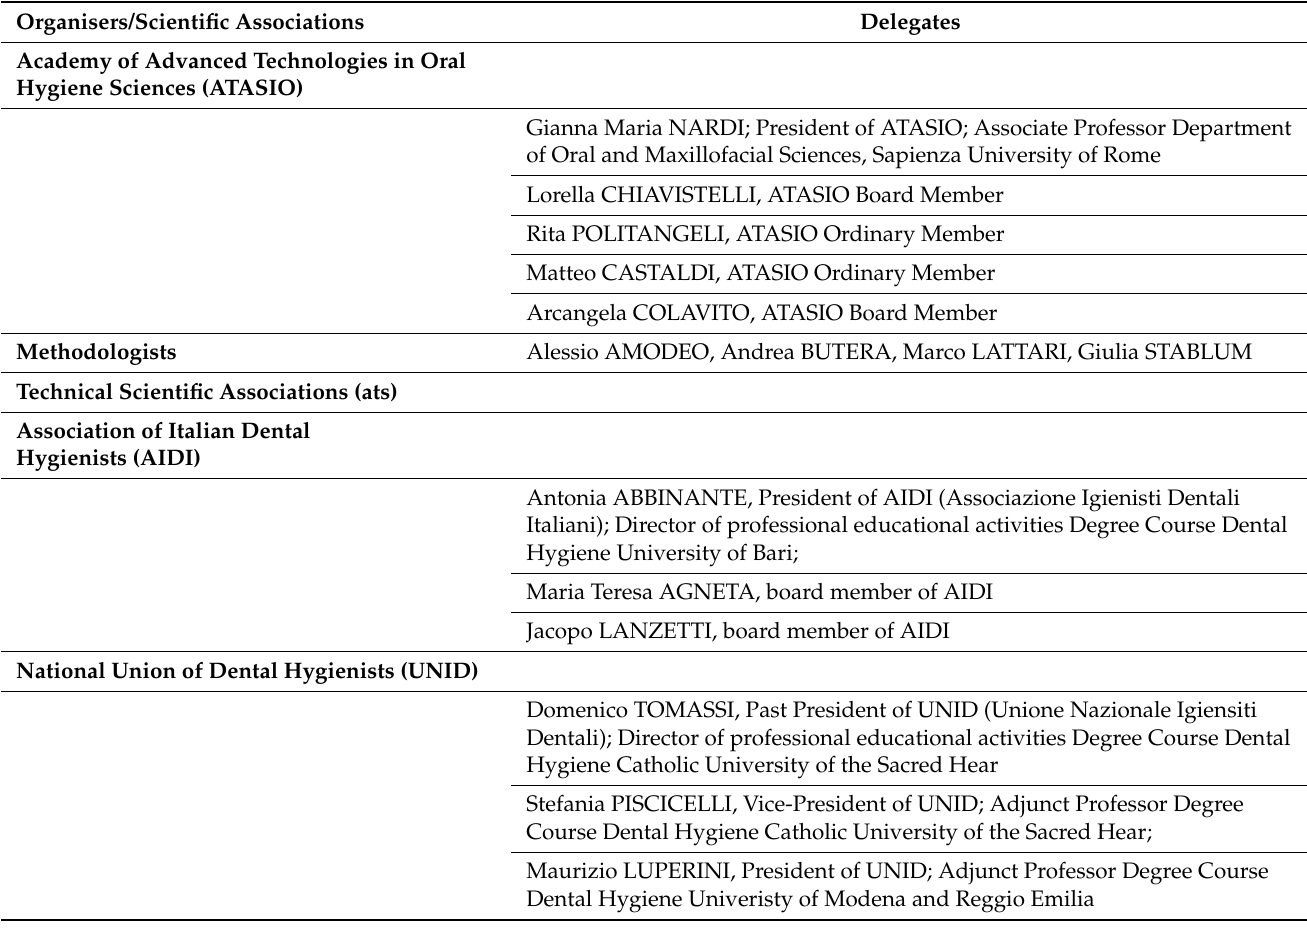
Table 1. Panel of 12 expert dental